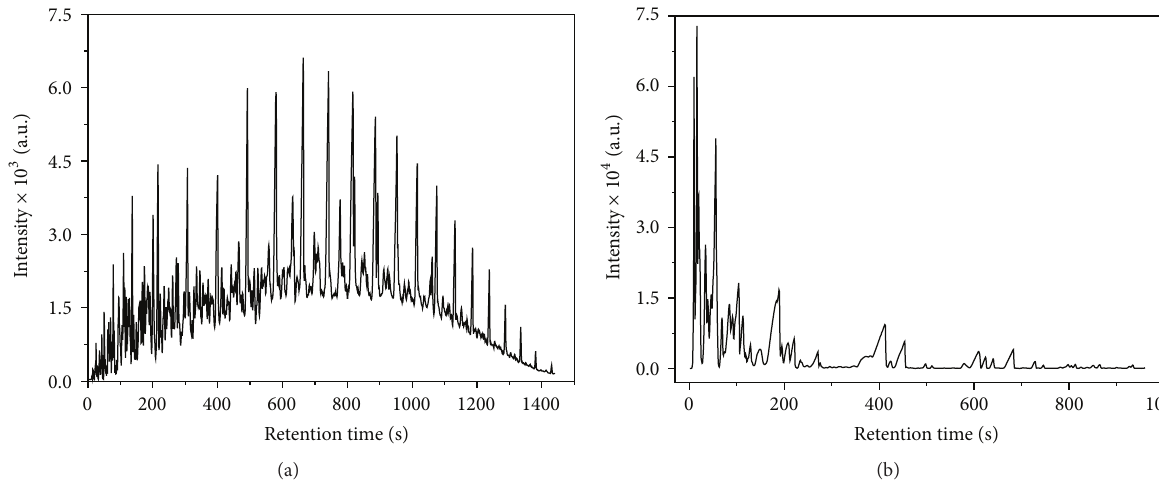
Figure 1: Characteristic chromatogram of (a) diesel sample and (b) gasoline sample.